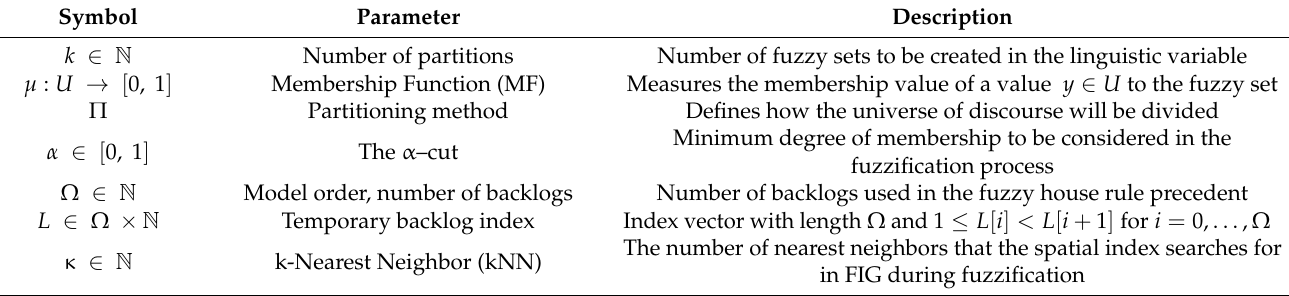
Table 1. Model Hyperparameters